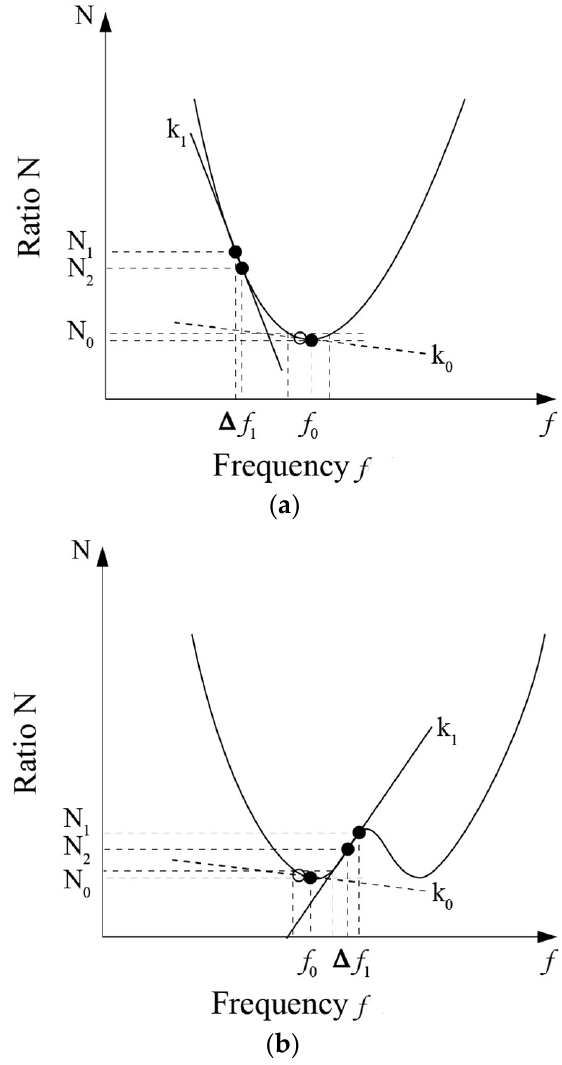
Figure 4. Relationship between the current ratio N and the trend of system operating frequency f: ( a ) frequency adjust without frequency bifurcation and ( b ) frequency adjust with frequency bifurcation.